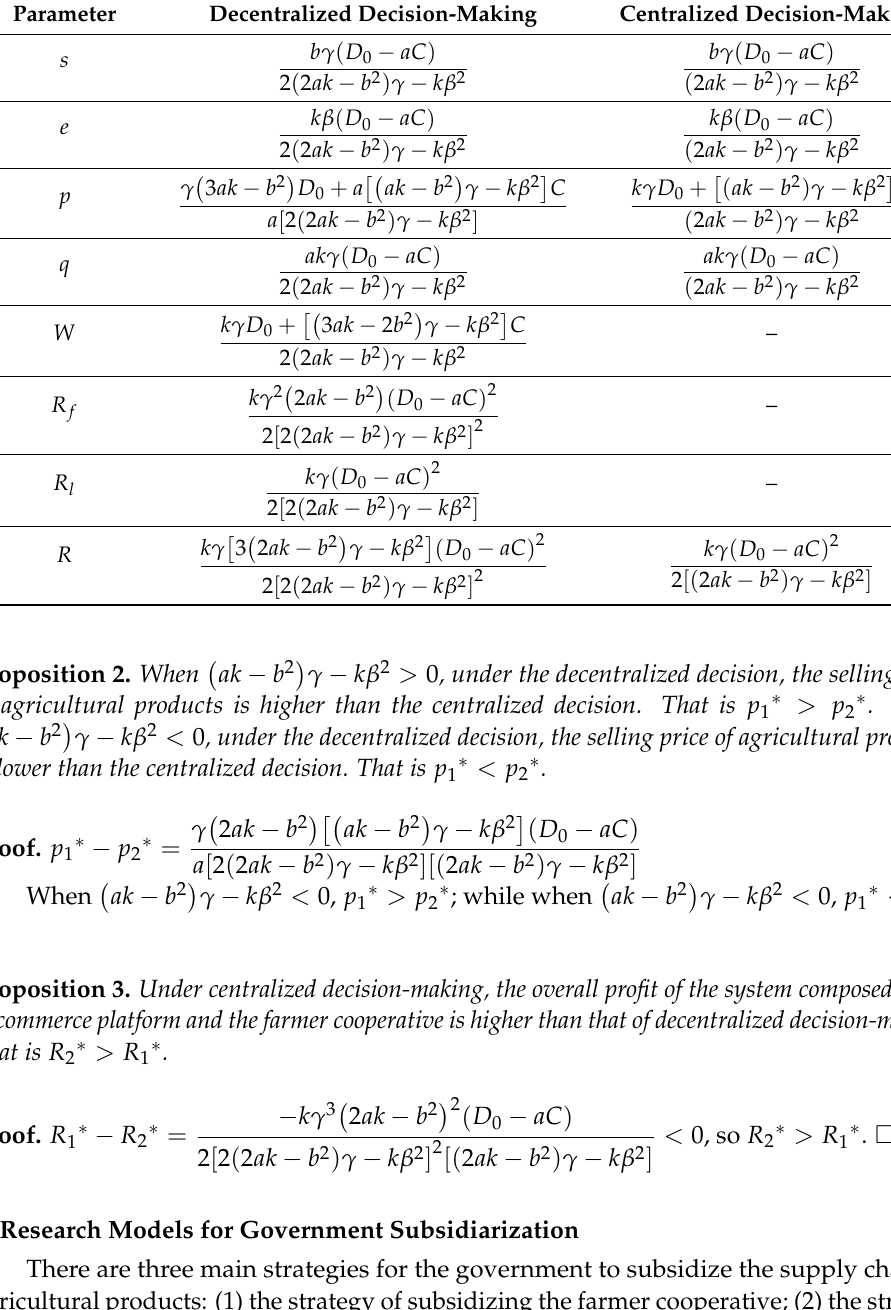
Table 2. Variable values and profits of different decision-making modes. Parameter Decentralized Decision-Making Centralized